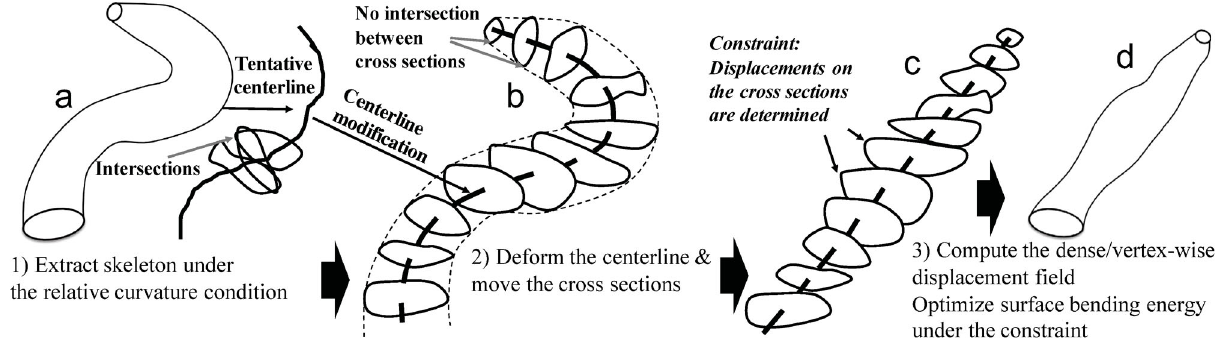
Fig. 2 Pipeline of skeleton-based GC deformation with relative curvature preservation. Input: a GC, and a target centerline shape. Output: a deformed version of the